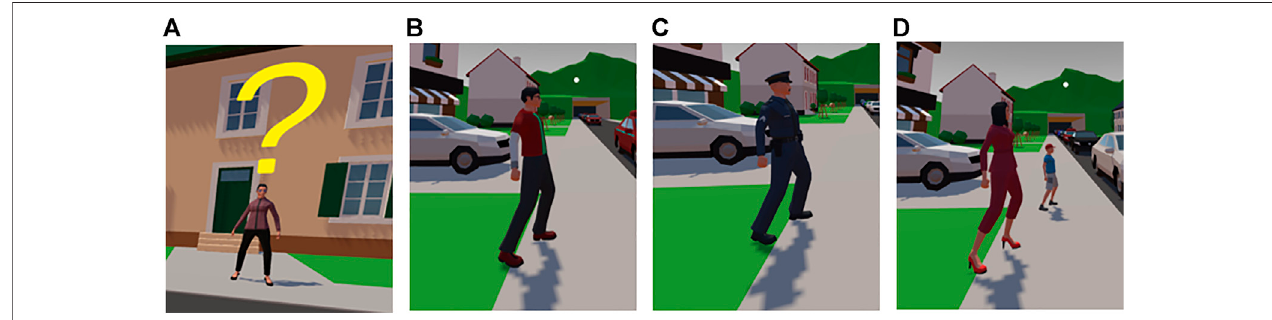
FIGURE 4 | Non-player characters. (A) Target customer waiting for pizza delivery. (B) A walking person who crosses the road represents negative social control. (C) Police of fi cer representing legal control. (D) Mother and child representing positive social control of abiding by the